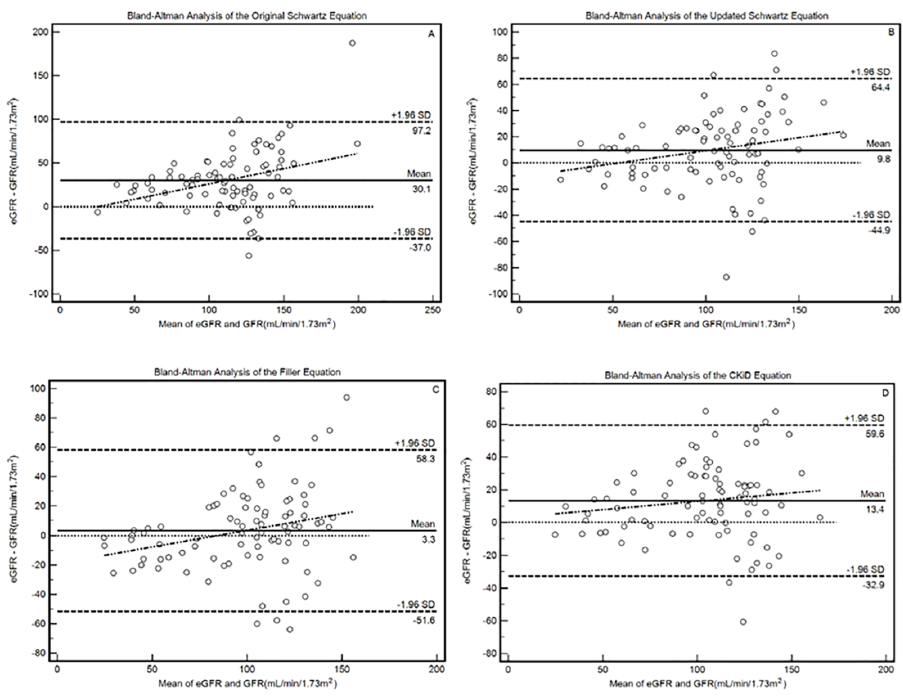
Fig 1. The Bland-Altman analysis of the four equations. The slopes in the Bland-Altman analysisof Schwartz1976 (originalSchwartz, A), Schwartz2009 (updatedSchwartz, B), Filler (C) and CKiD (D) equations are 0.35 (95% CI [0.14, 0.56]), 0.20 (95% CI [0.02, 0.38]), 0.23 (95% CI [0.05, 0.23]) and 0.10, (95% CI [-0.06, 0.26]), respectively.